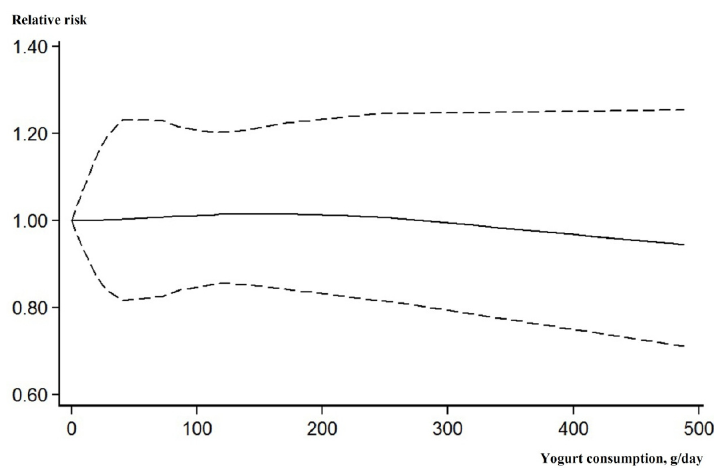
Figure 3. Dose ‐ response association between yogurt consumption (g/day) and the incident risk of Dose-response association between yogurt consumption (g/day) and the incident cardiovascular disease. Solid line, best ‐ fitting restricted cubic spine; dotted line, 95% confidence interval. risk of cardiovascular disease. Solid line, best-fitting restricted cubic spine; dotted line, 95% confidence